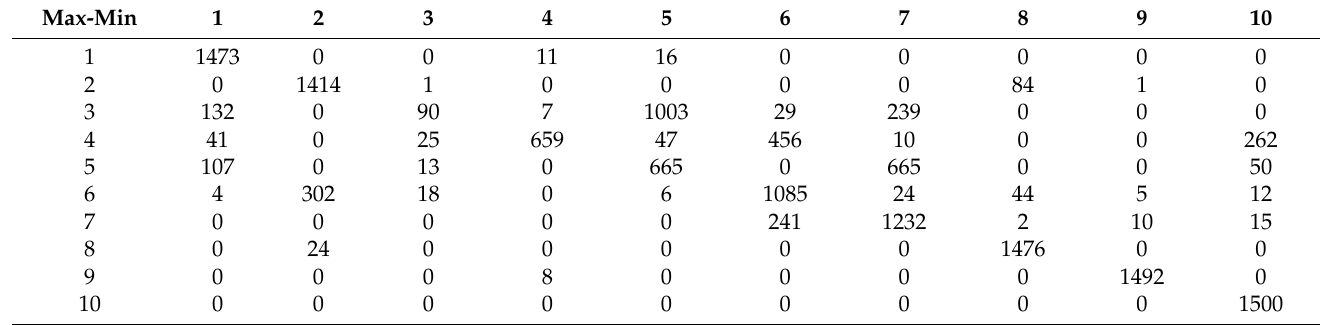
Table 5. The confusion matrix of hand gesture intention recognition by VGG-16 CNN deep learning with wavelet image fusion of the merge type of “max-min” on the recognition system